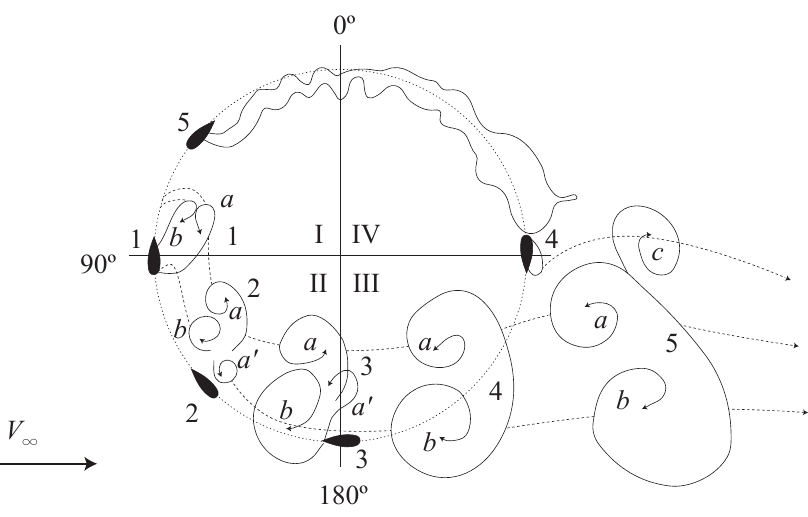
Figure 8. Dynamic vortex shedding for a straight-bladed vertical axis turbine operating in a towing tank at the tip speed ratio (TSR) of 2.14, obtained from [32]. a , a (cid:48) , b and c denote